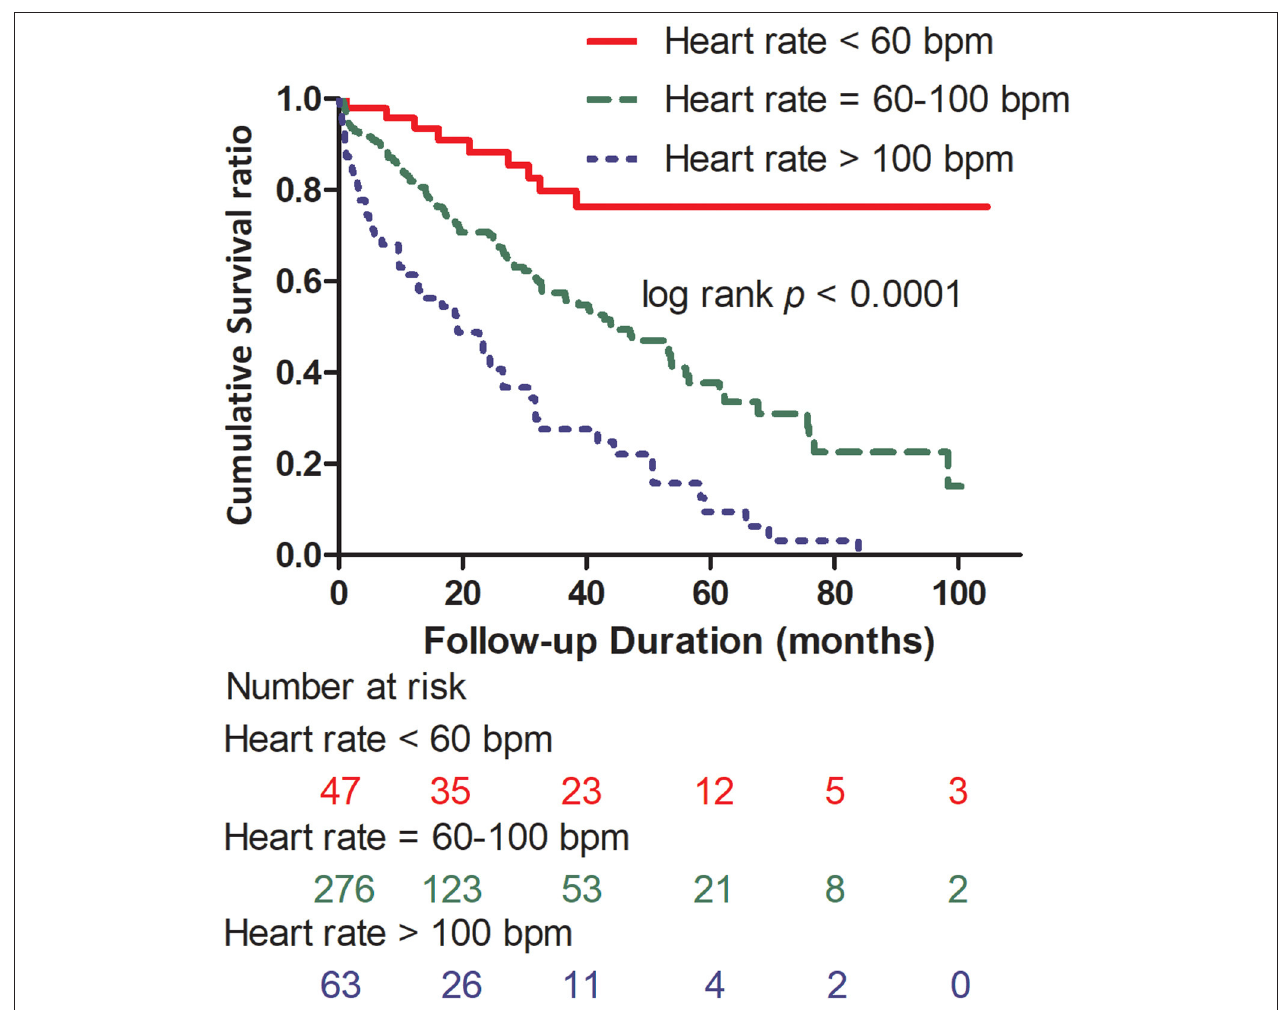
FIGURE 1 | Kaplan–Meier survival curves according to the presence of heart rate > 100 bpm, 60 ≤ heart rate ≤ 100 bpm, and heart rate < 60 bpm, log-rank p < 0.0001. HR, heart rate; bpm, beats per minute.